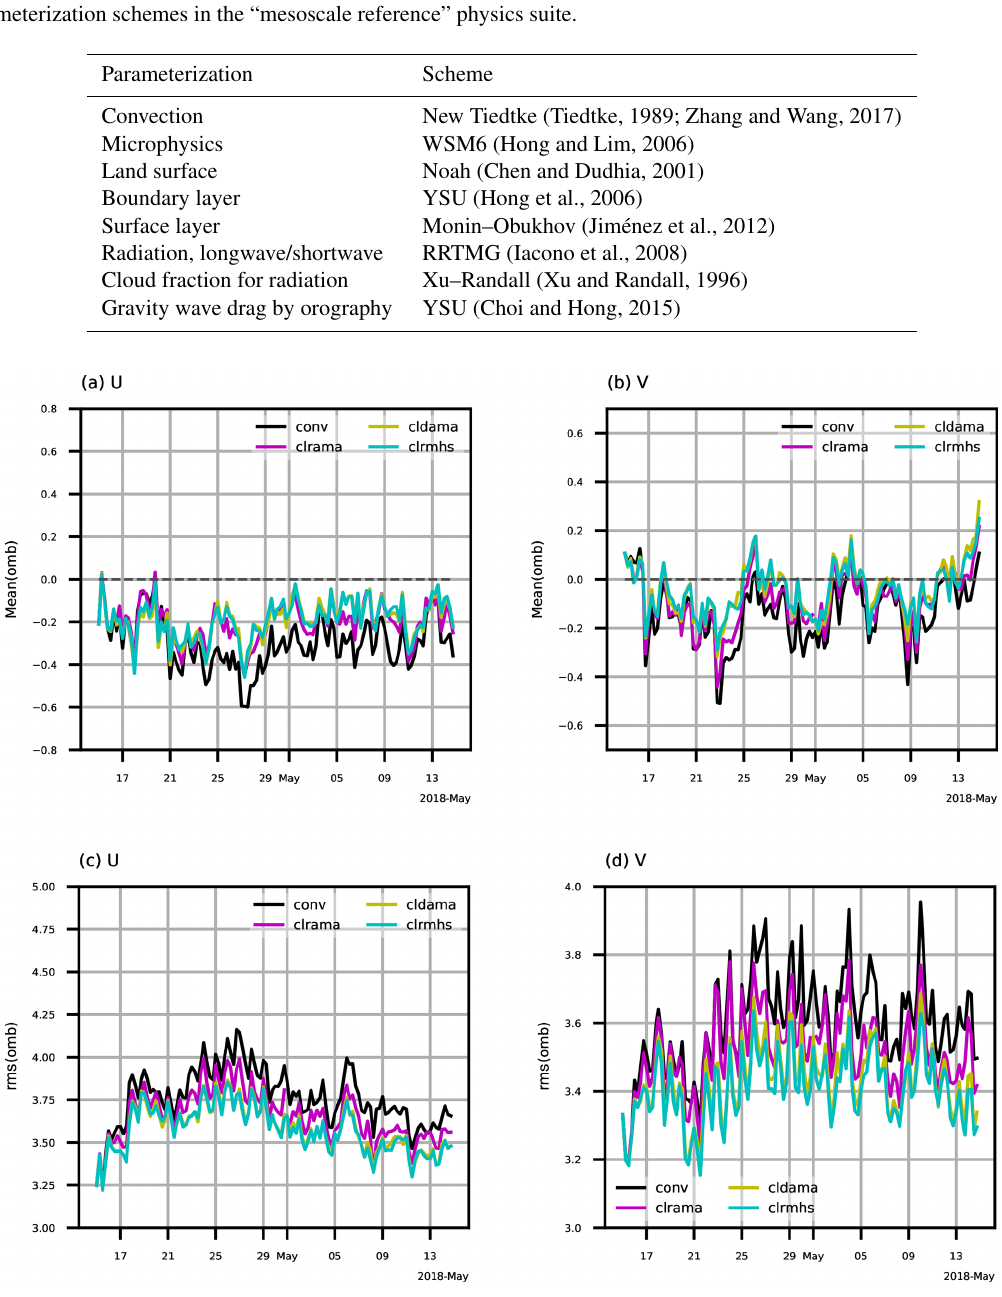
Figure 2. Time series (00:00UTC, 15 April–18:00UTC, 14 May 2018) of (a, b) mean and (c, d) rms of OMB for AMV (a, c) zonal and (b, d) meridional wind components (units: ms − 1 ) from the four experiments. The background is a 6h forecast. Statistics are computed over the globe and averaged for all vertical